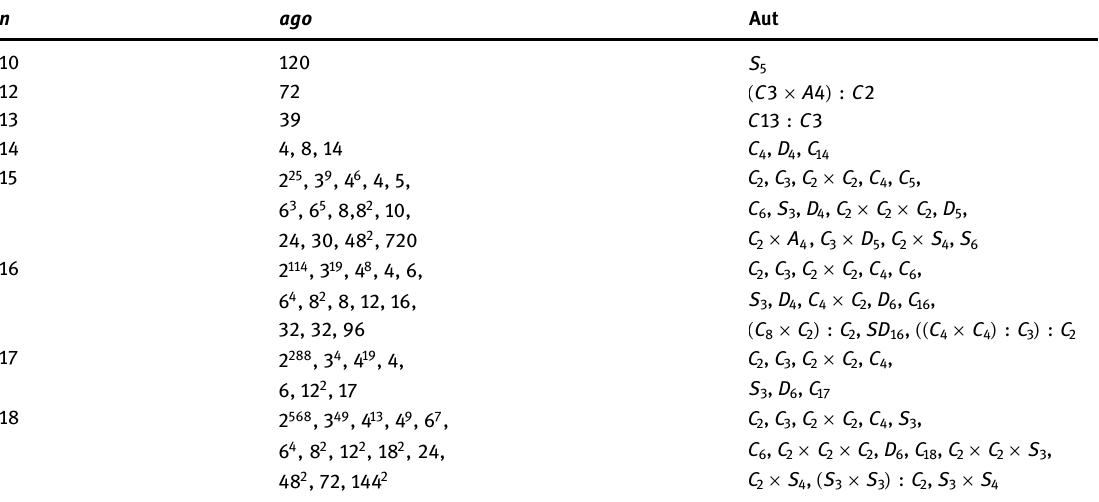
Table 3: Automorphism group types ( excluding trivial groups )